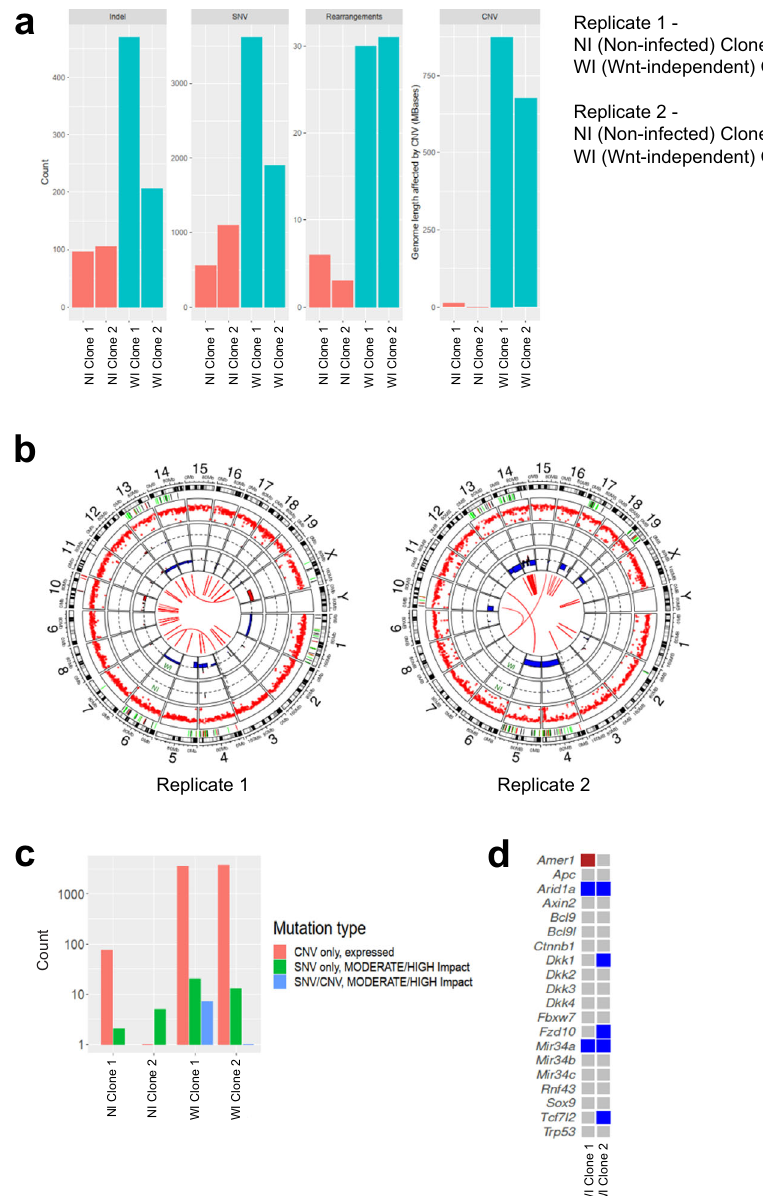
Fig. 4 Wnt-independent organoids have major chromosomal aberrations and high mutational load. a The number of detected insertions and deletions (indels), somatic single nucleotide variants (SNV), and detected rearrangement breakpoints (Rearrangements) in Wnt-independent (WI) and non-infected (NI) organoids in two independent replicates from whole-genome sequencing (WGS). Genome length affected by copy number variations (CNV) for Wnt- independent (WI) and non-infected (NI) organoids in two independent replicates from WGS. Each condition was compared to the pool of non-infected organoids of that respective experiment. b Circos plots showing CNV, SNV, indels, structural variants, and mutated genes in the Wnt-independent organoids for replicates 1 and 2 from WGS. Each section represents chromosomes 1 – 19, chromosome X, and chromosome Y. The central part shows aberrant genomic fusions in the Wnt-independent condition. The two innermost circles (WI and NI) represent CNV in non-infected (NI) organoid clones and Wnt-independent (WI) organoid clones, respectively. The blue (genomic loss) and red (genomic gain) regions represent CNV. All losses of chromosomal regions are heterozygous. Each condition was compared to all the non-infected organoids of that respective replicate. A rainfall plot (red dots) shows the SNV and indel variations and the distances between them on the y -axis only for the Wnt-independent condition. The green, orange, and black lines depict positions of mutated Wnt pathway genes, known cancer driver genes, and p53 pathway genes, respectively, in the Wnt-independent condition. c The number of genes affected in each sample by CNV and/or SNV analyzed by WGS. For CNV, only genes expressed in non-infected controls were considered. For SNV, only mutations that change the amino acid sequence are shown. d Mutational status of genes of the Wnt pathway that are frequently affected in CRC, genes of the micro-RNA-34 family, and Trp53 . Blue, genomic loss; red, genomic gain. Source data are provided as a Source Data fi